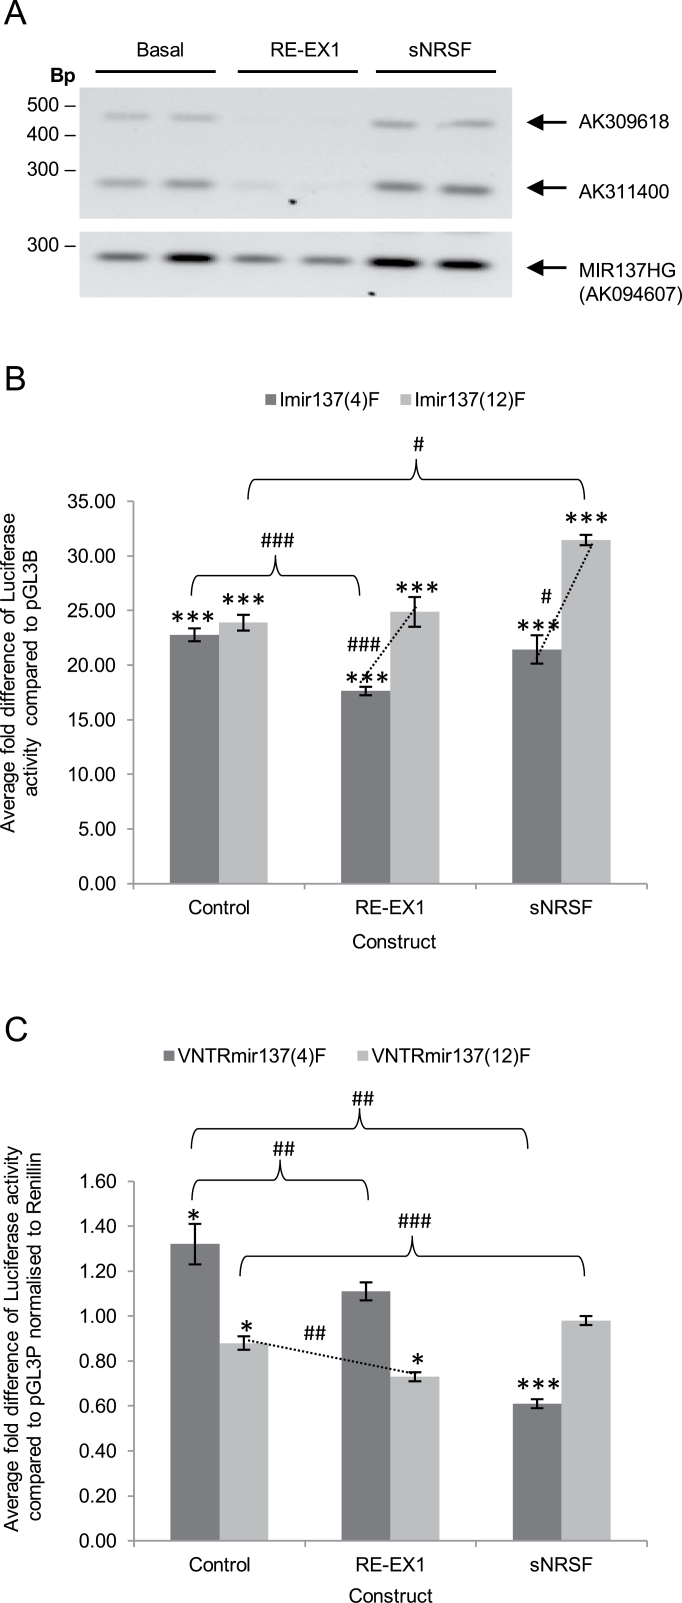
Differential regulation of the MIR137 locus after REST overexpression in SH-SY5Y cells. (A) Expression of AK311400, AK309618, and MIR137HG/AK094607 mRNA after overexpression of full-length human REST (RE-EX1) and sNRSF. Expected band sizes for AK311400, AK309618, and MIR137HG were 274, 451, and 291bp, respectively. (B,C) Average fold change in luciferase activity compared to pGL3B (B) and pGL3P (C) controls after transfection of MIR137 reporter gene constructs under basal conditions or in combination with RE-EX1 or sNRSF overexpression constructs. N = 4. *Significant changes in luciferase activity over backbone control. #Significant changes in luciferase activity between experimental conditions. */#
P < .05, **/##
P < .01, ***/###
P < .001.